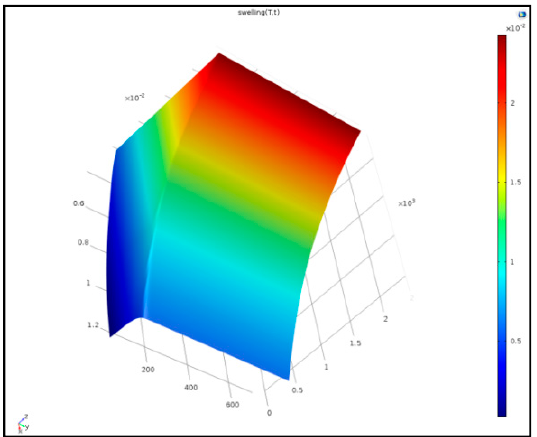
Figure 1. Variation of the swelling silicon carbide (SiC) material as functions of temperature and neutron flux.